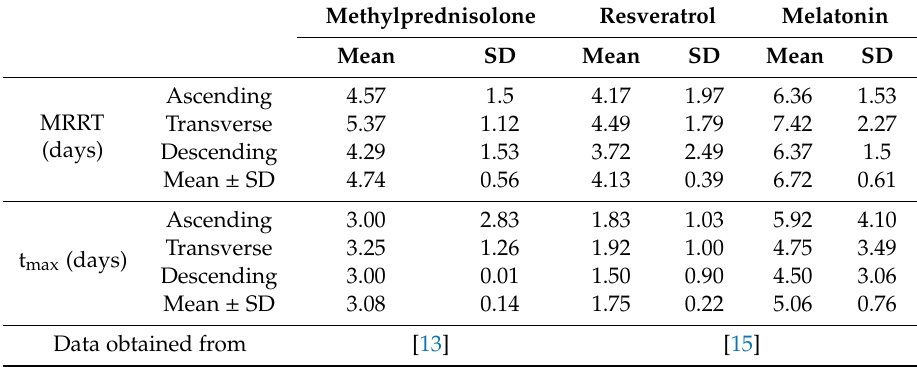
Table 2. MRRT and t max values of rats treated with the corticosteroid methylprednisolone, resveratrol and melatonin. The parameters were calculated from data from previously published